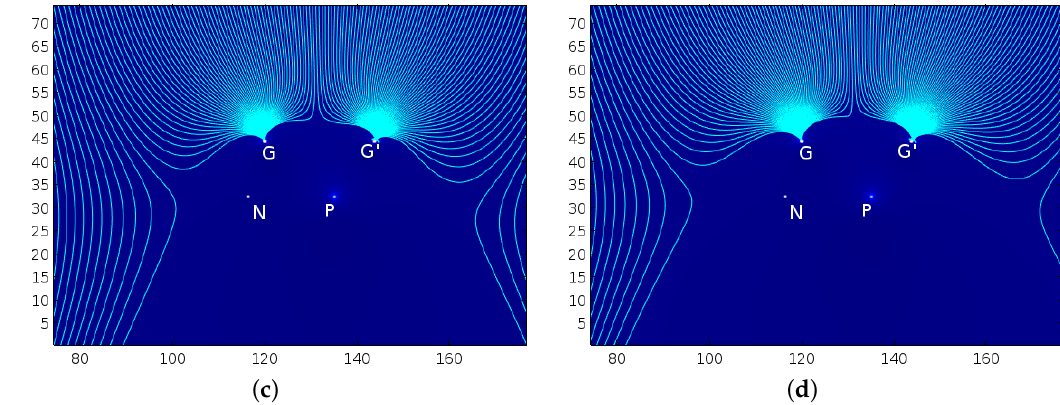
Figure 12. Lightning incidence, as given by EFD Model, for the span region with proposed modifications. ( a ) I p = 2.9 kA, ( b ) 5.4 kA, ( c ) 10.1 kA and ( d ) 15.7